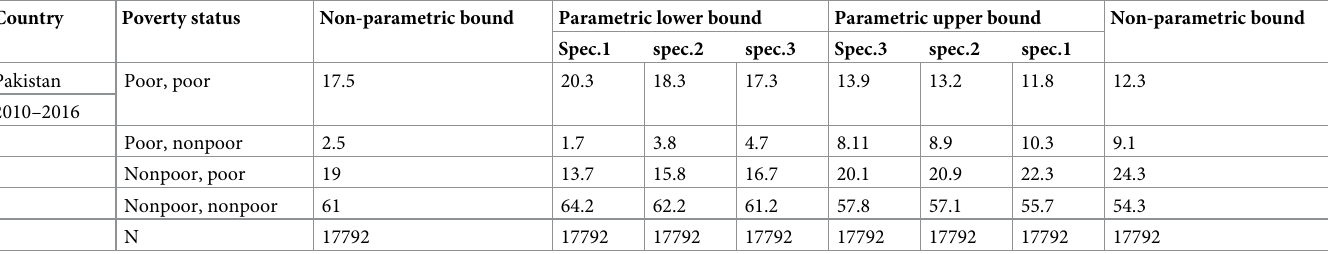
Note: Estimated poverty rates percentage using HIES cross sectional data, second survey round used to obtained predictions. Non-parametric estimates replications are 500. Household head age restricted between 25 and 55 for both survey